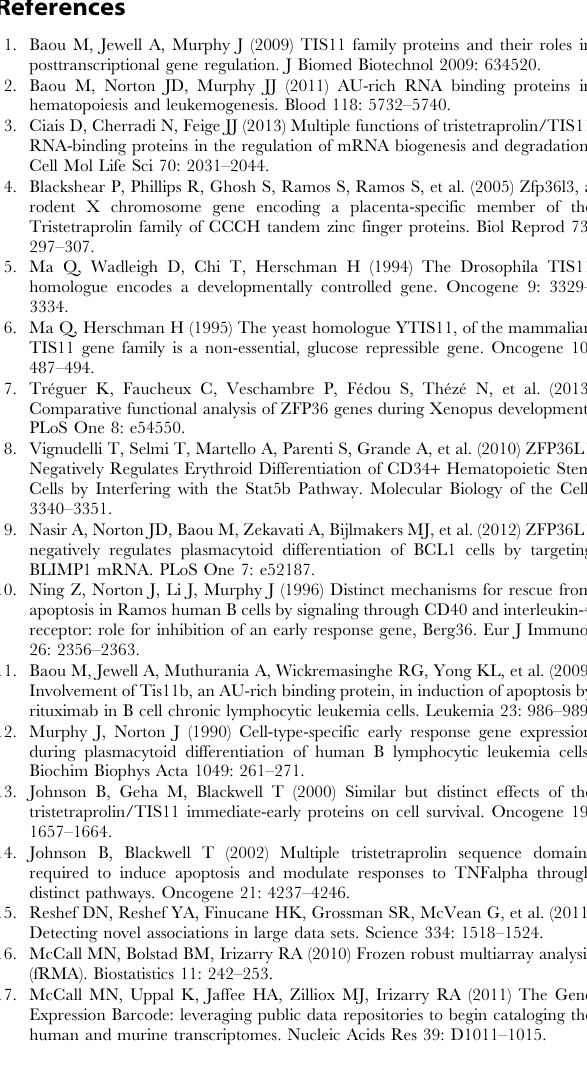
Table S1 Inferred target mRNAs for ZFP36 family members. Table S2 Enrichment of Gene Ontology terms (Biolog- ical Process) in inferred ZFP36 family target